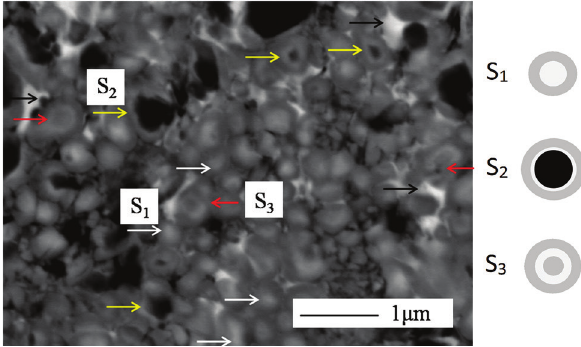
Fig. 2: EPMA (BSE) micrographs of Ti(C,N) based cermets and schematic of the three core-ring